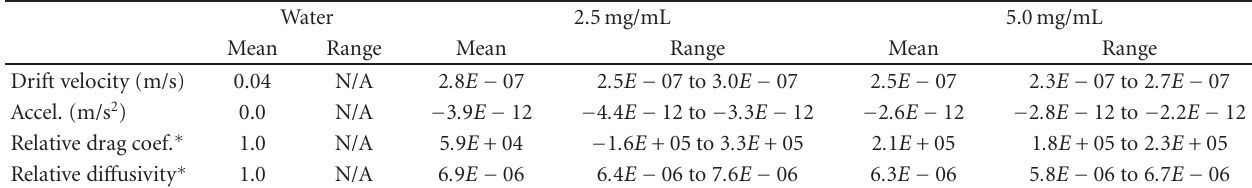
Table 3: Summary of results pertaining to trypan blue di ff usion through collagen gels. The di ff usivity for both cell densities is roughly the same. ∗ Relative drag coe ffi cient and relative di ff usivity values were calculated by normalizing against that of water (there was no significant di ff erence between the di ff usivity values of the 2.5mg/mL and 5.0mg/mL